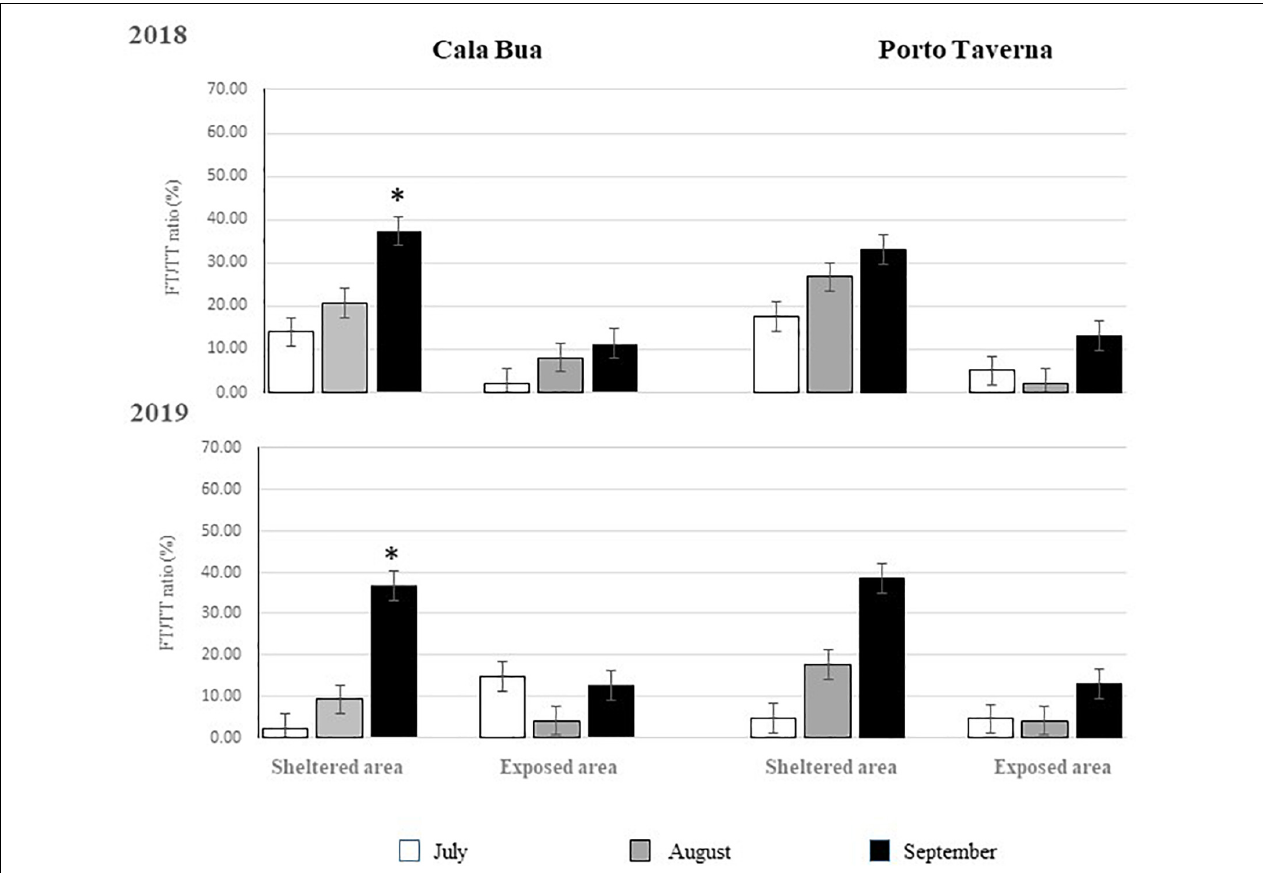
FIGURE 5 | Mean ( ± ES) ratio between the number of fertile thalli and the total number of thalli (FT/TT %) in the two areas of the two study sites during each of the three periods considered for each study year. Spawning events are indicated with ∗ .